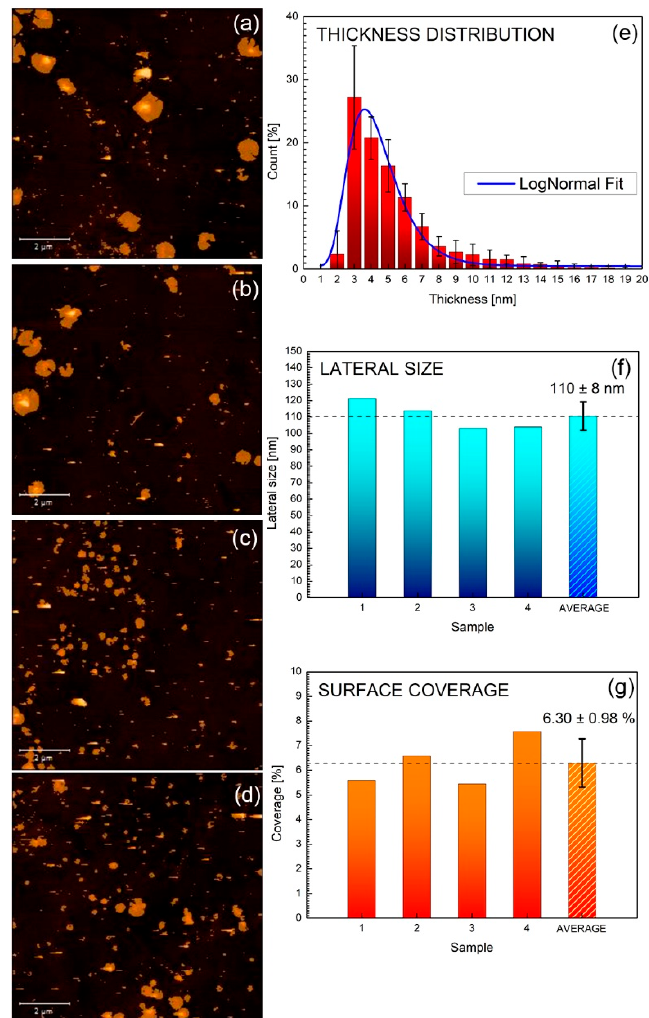
Figure 4. ( a – d ) AFM images of WS 2 exfoliated corresponding to four different samples prepared under the same conditions (i.e., 2 h ball milling and 90 min sonication). Statistical analysis corresponding to thickness distribution ( e ), Lateral dimensions ( f ) and surface area coverage ( g ).